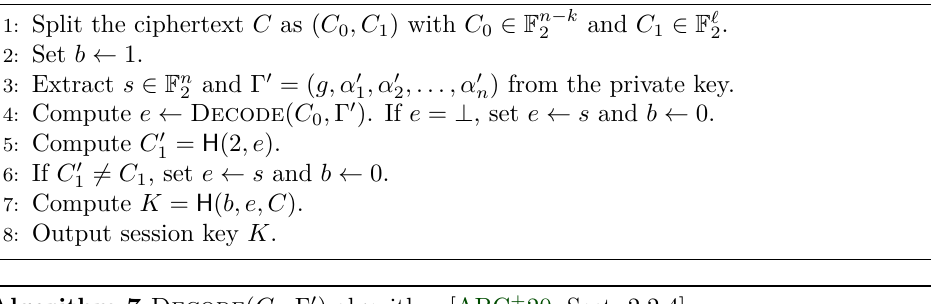
Algorithm 6 Decap (( δ, c, g, α, s ) , C ) algorithm [ABC + 20, Sect. 2.3.3].